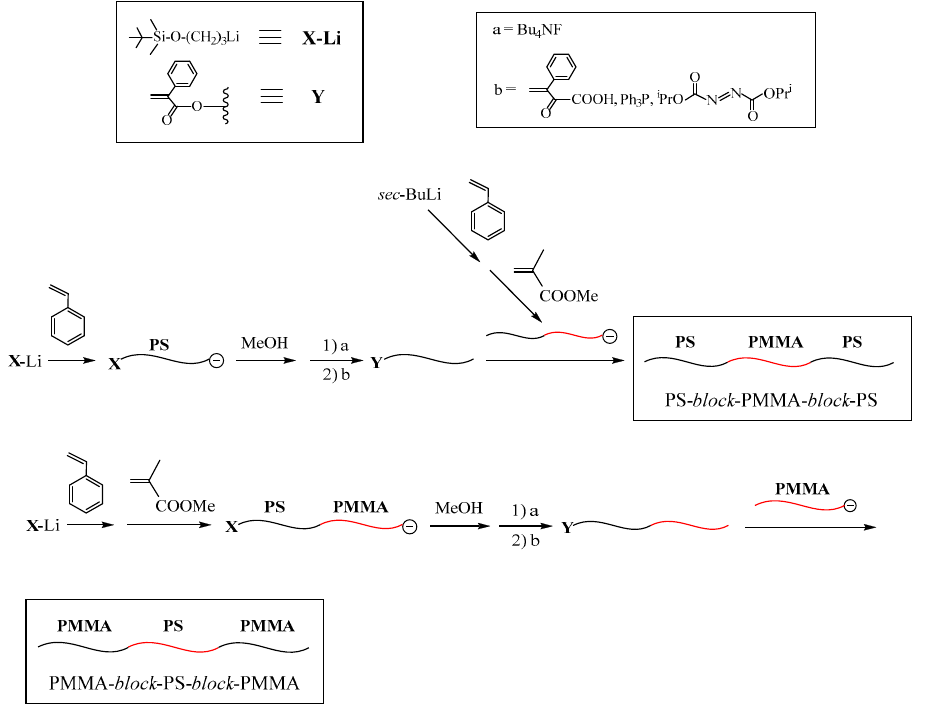
Table 9. Relationships among monomers and chain-end anions in